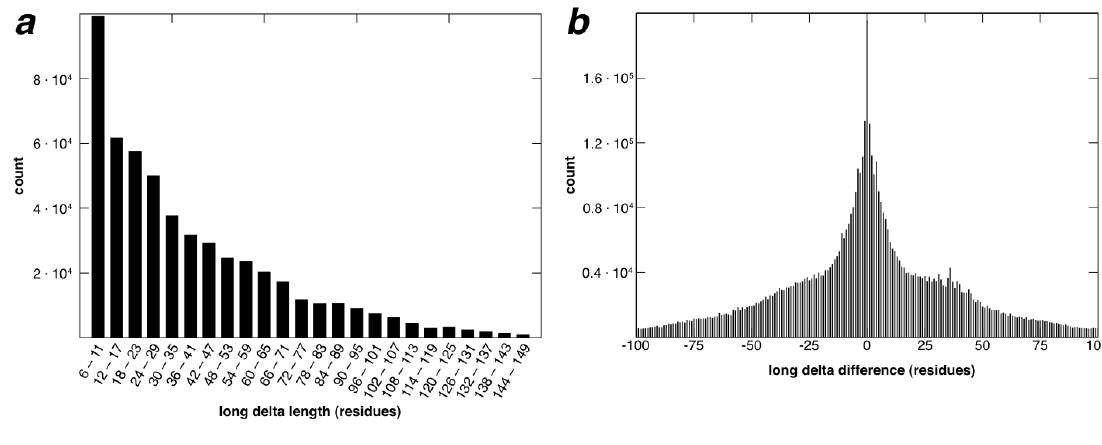
Figure 7. Long delta properties. ( a ) Distribution of long delta lengths for the RSMs at the lowest cutoff value in Table 1; ( b ) distribution of differences between long delta values for RSMs in Table 1 (lowest RMSD cutoff) and their associated search-set